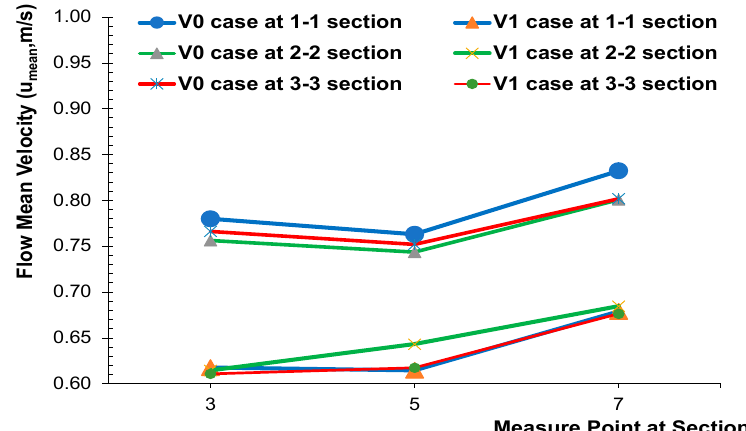
Figure 15. Flow velocity change according to the V 0 case and V 1 case. Flow velocity profiles made without a submerged vane are compatible with numer- ical model or experiment results ([19,30]). Reported laboratory experiments show flow patterns of submerged vanes. Scour in the outer meander was caused by the increase in flow velocity and shear stress. The submerged vane cuts off secondary circulation or cross flow cuts off thereby reducing high velocities around the outer meander (Figures 10, 11 and 15). This study investigated the effects of submerged vane structures on flow rates and water depth. As a result of this study, it was determined that submerged vane struc- tures decrease the maximum and average velocity along the depth, decrease the flow ve- locity at 06 d and direct it to the inner bank. In the meander section of the open channel, velocity distribution diagrams of the submerged vaneless streamflow bed (Figures 7 and 8) show that it slides out of the meander and reaches the maximum level near the outer meander before the outlet of the meander. This experimental pattern was consistent with experimental measurements in the other channel meander [19]. The centrifugal force in- creases proportionally with the square of the flow velocity and the upper region with high flow velocity reaches more centrifugal force than the lower region [30]. Experimental flow velocity results measured at 0.6 d, modeled both with submerged vane and without sub- merged vane, showed that the model with submerged vane decreased the flow velocity by 16–27% and directed the flow (Figures 7, 9 and 11). When the literature studies were examined, Gemici [7] experimentally found that submerged vane flow velocities were re- duced by 7–19%. The flow models obtained with the 3D model were examined along with the depth (Figure 11), and it was observed that the mean velocity was reduced by 19–21% (Figures 14 and 15). The result of this study will be useful for understanding the flow phenomenon, validation of numerical work and subsequent design of meander protection measures.